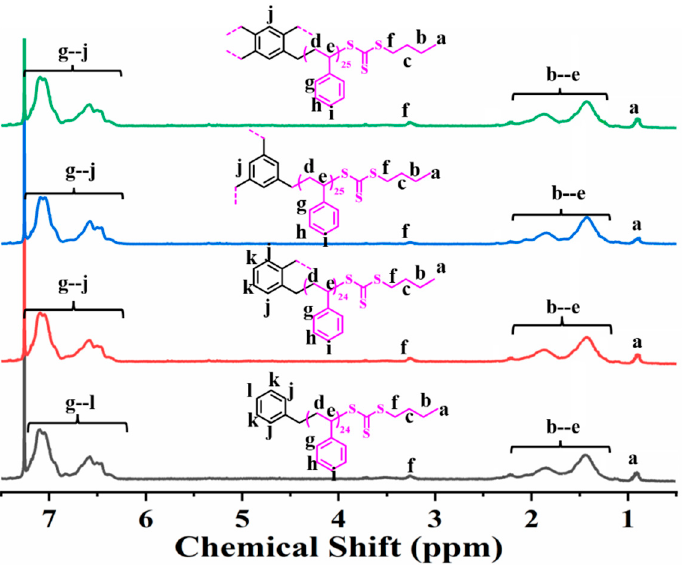
Figure 1. 1 H NMR spectra of (PS-TTC)n (n = 1, 2, 3, 4) with similar PS arms chain at about 25.